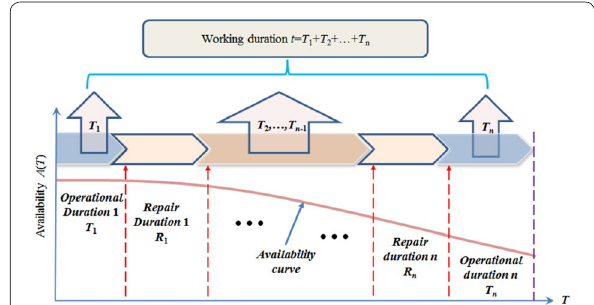
Figure 6 Availability with respect to T